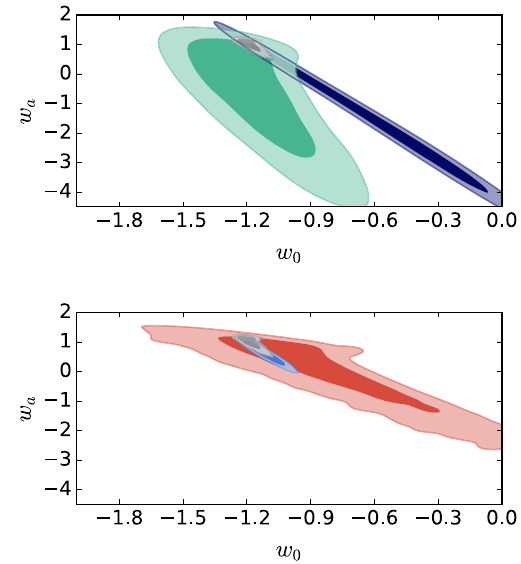
Fig. 3 Contours in the w 0 – w a plane for CPL; solid contours are for 1 σ regions and clear contours are for 2 σ regions. Top panel: purple is for the BAO data; green for SNe and gray for SNe + BAO. Bottom panel: red is for 32 years SL data; gray for SNe + BAO; blue for SNe + BAO +